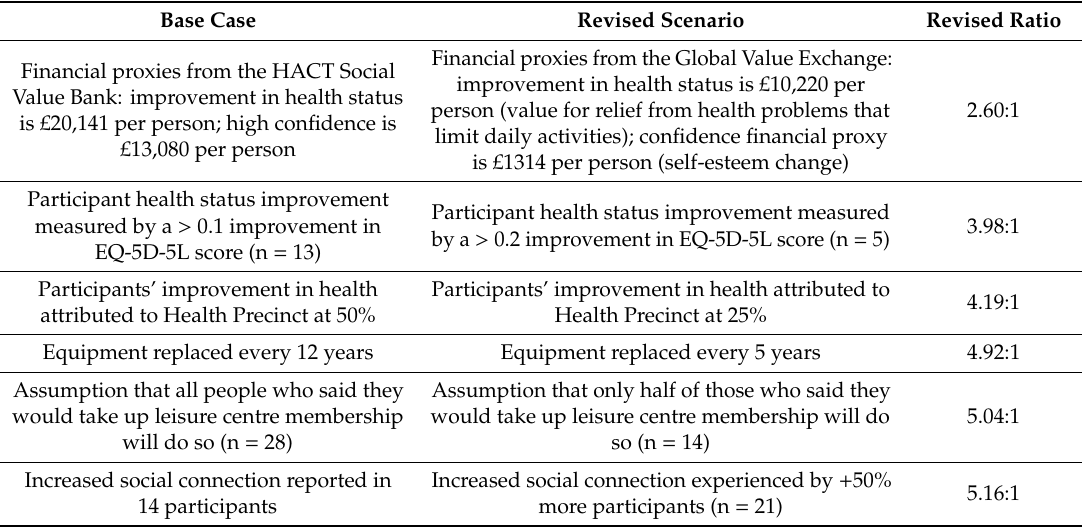
Table 4. Sensitivity